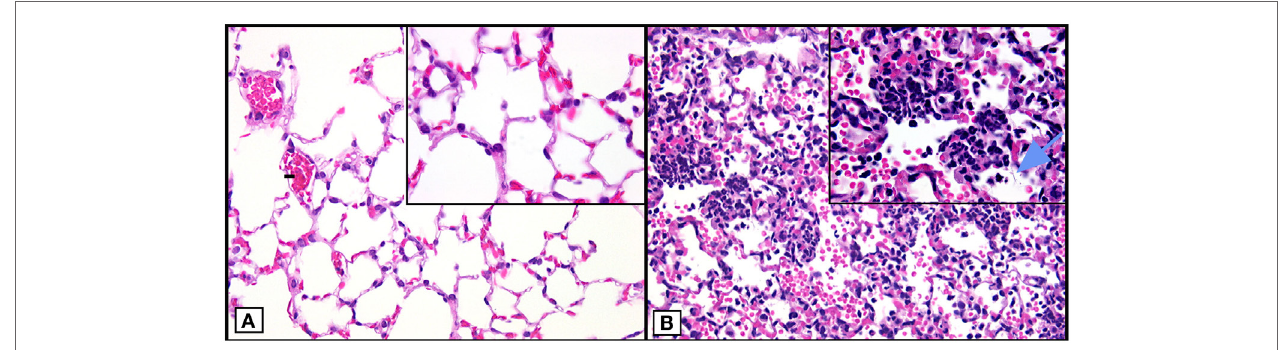
FiGURe 1 | Histopathology of mouse lungs in normal lungs and lungs after ALi following airway deposition of igGiC in C57BL/6J mice . (A) Histological features of normal mouse lung. (B) Positive control (acutely injured lung induced by airway deposition of IgGIC) 6 h after induction of ALI showing lung infiltration of PMNs, intra-alveolar hemorrhage, and hyaline membranes (arrow). Images modified from Bosmann et al. (18). Both frames are from paraffin-embedded sections stained with hematoxylin and eosin ( × 40 view; insets: × 100